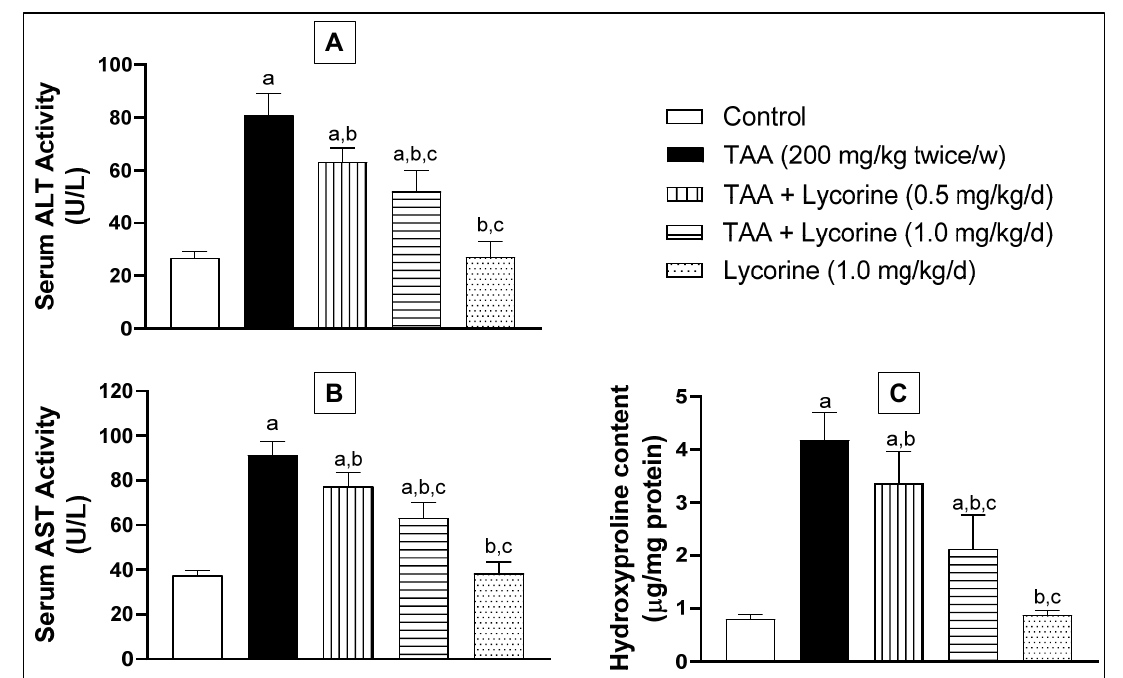
Figure 1. Effect of lycorine on ( A ) serum ALT activity, ( B ) serum AST activity, and ( C ) hepatic hydroxyproline in a rat model of TAA-induced liver fibrosis. Data are displayed as mean ± S.D. n = 6. Statistical analysis was carried out by one-way ANOVA followed by Tukey’s post- hoc test. (a) Statistical significance from the corresponding control at p < 0.05. (b) Statistical significance from TAA-challenged group at p < 0.05. (c) Statistical significance from the TAA + lycorine 0.5 mg/kg/d group at p < 0.05. TAA: thioacetamide; ALT: alanine transaminase; AST: aspartate transaminase.